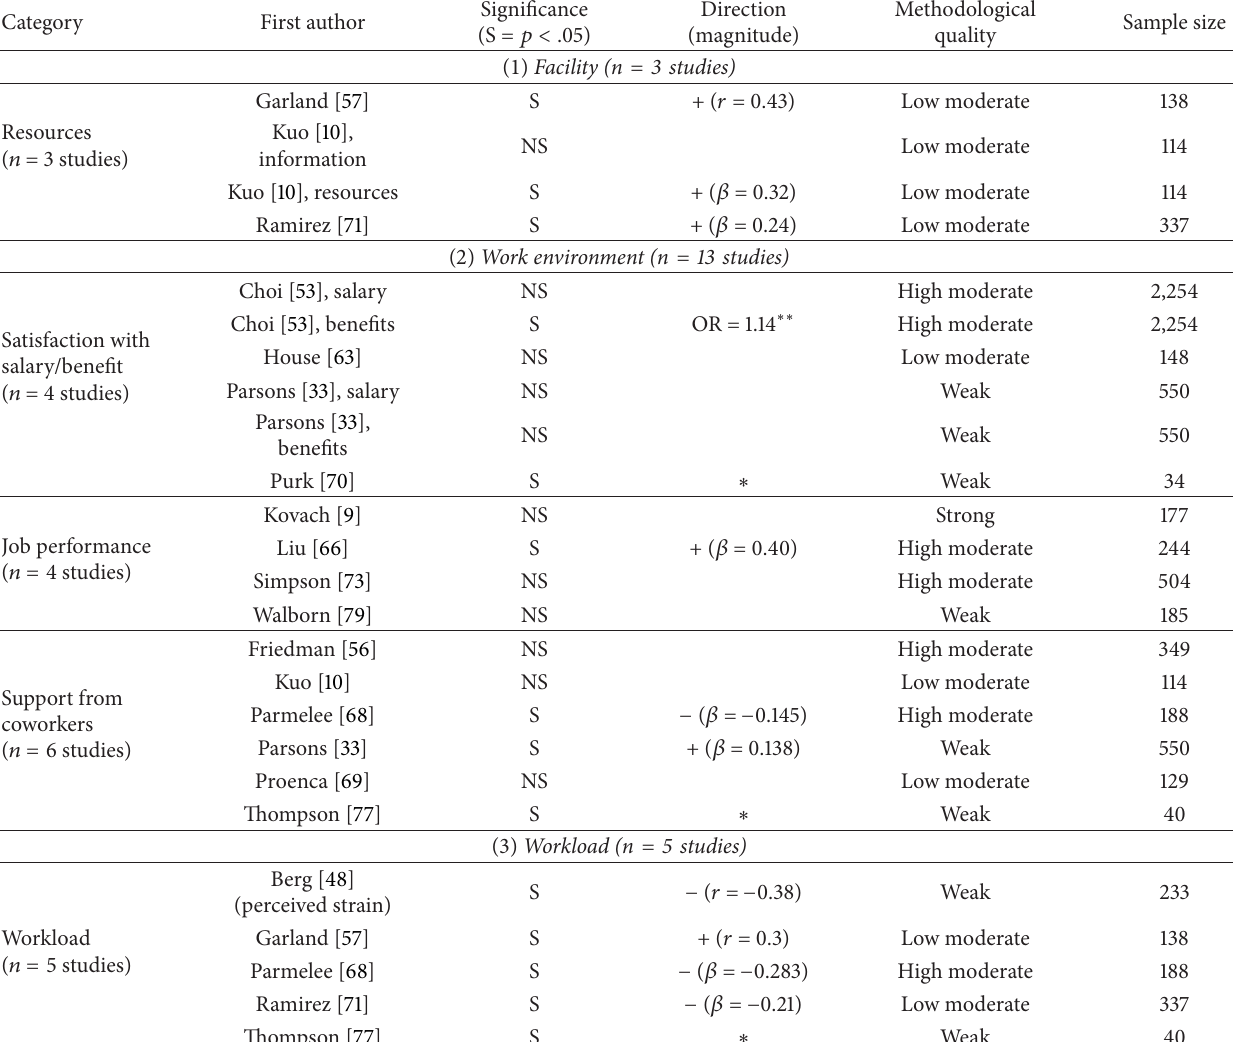
Table 4: Organizational factors (reported four or more